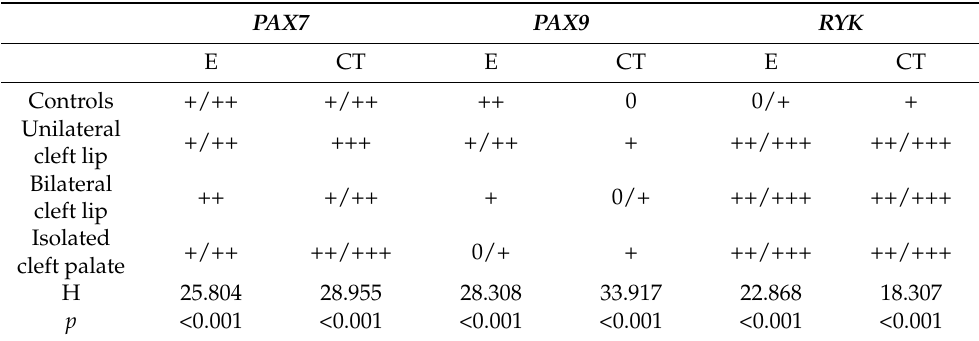
Table 1. Summary of semiquantitative evaluation showing the median values of PAX7 , PAX9 , and RYK immunoreactivity in the control group, unilateral cleft lip patient group, bilateral cleft lip patient group, and isolated cleft palate patient